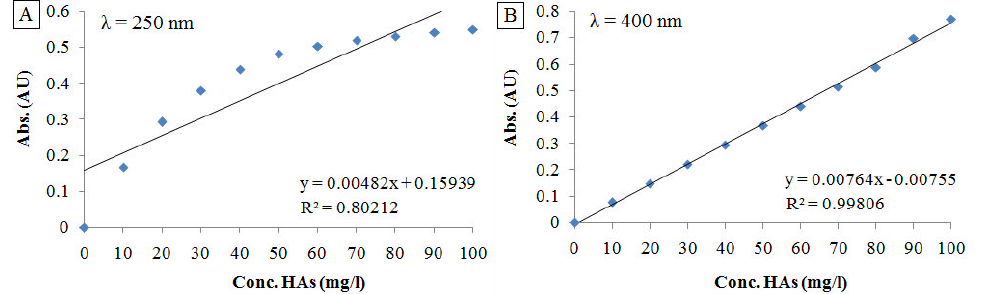
Figure 4. The influence of the wavelength value in the HAs Table 3. The HAs recovery by using different eluents (200 mL ultrapure water spiked with 1 mg HAs).